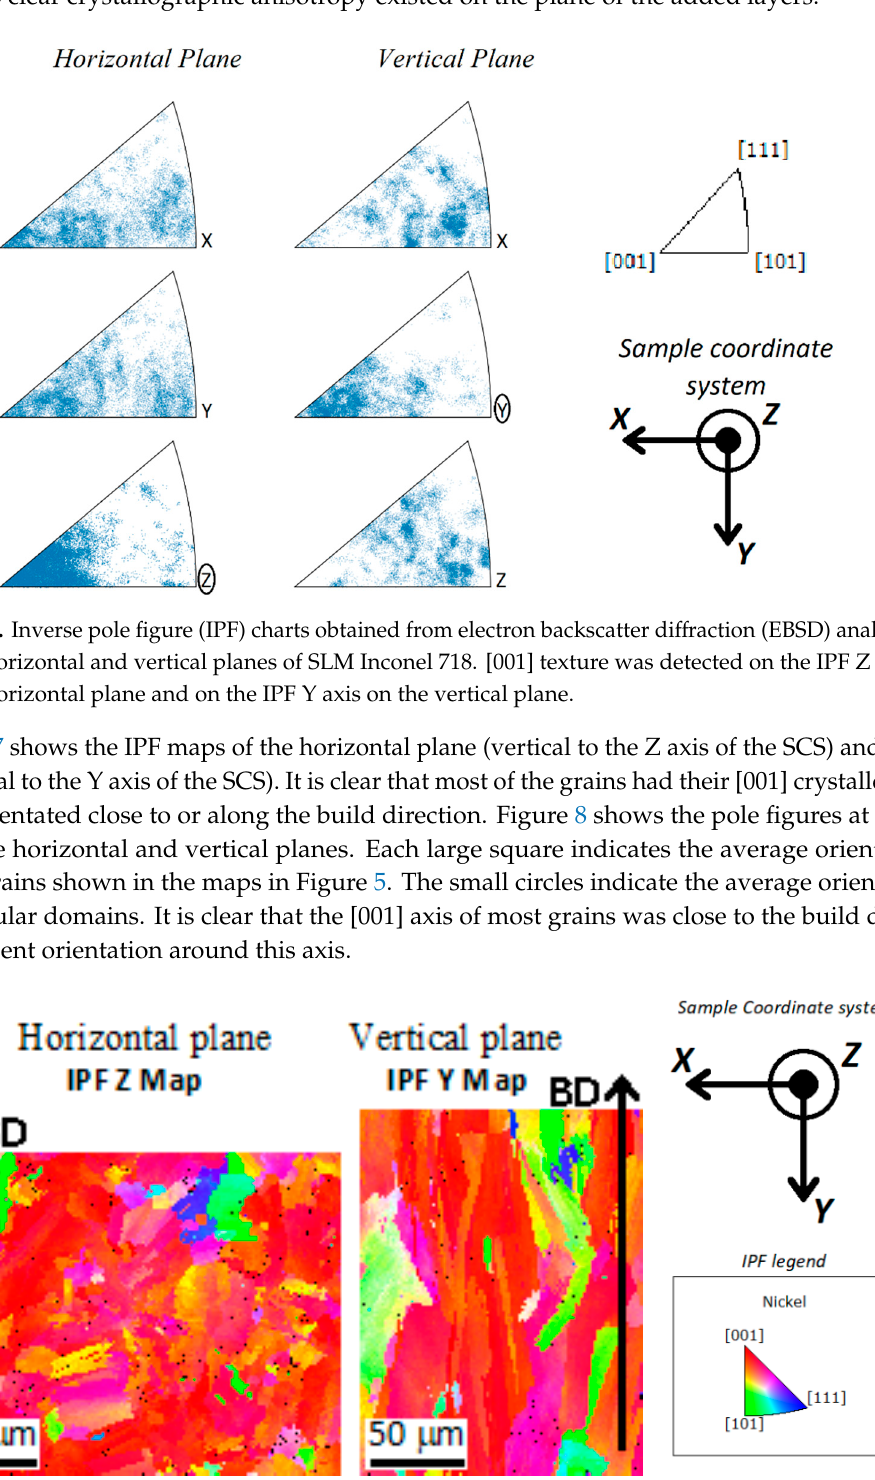
Figure 7. Inverse Pole Figure (IPF) maps of the Z axis for the horizontal plane and Y axis for the vertical plane showing grains with [001] orientation.